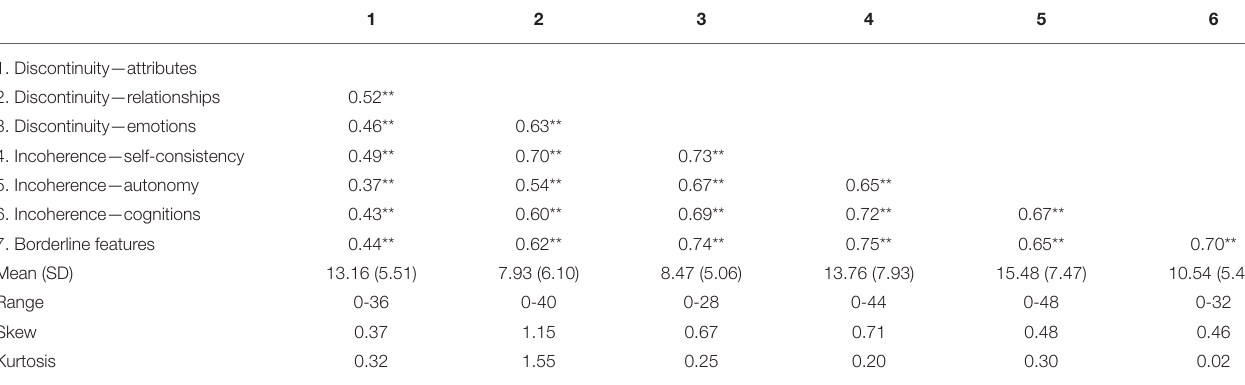
TABLE 1 | Descriptive statistics and correlations for AIDA scales in full sample ( N =